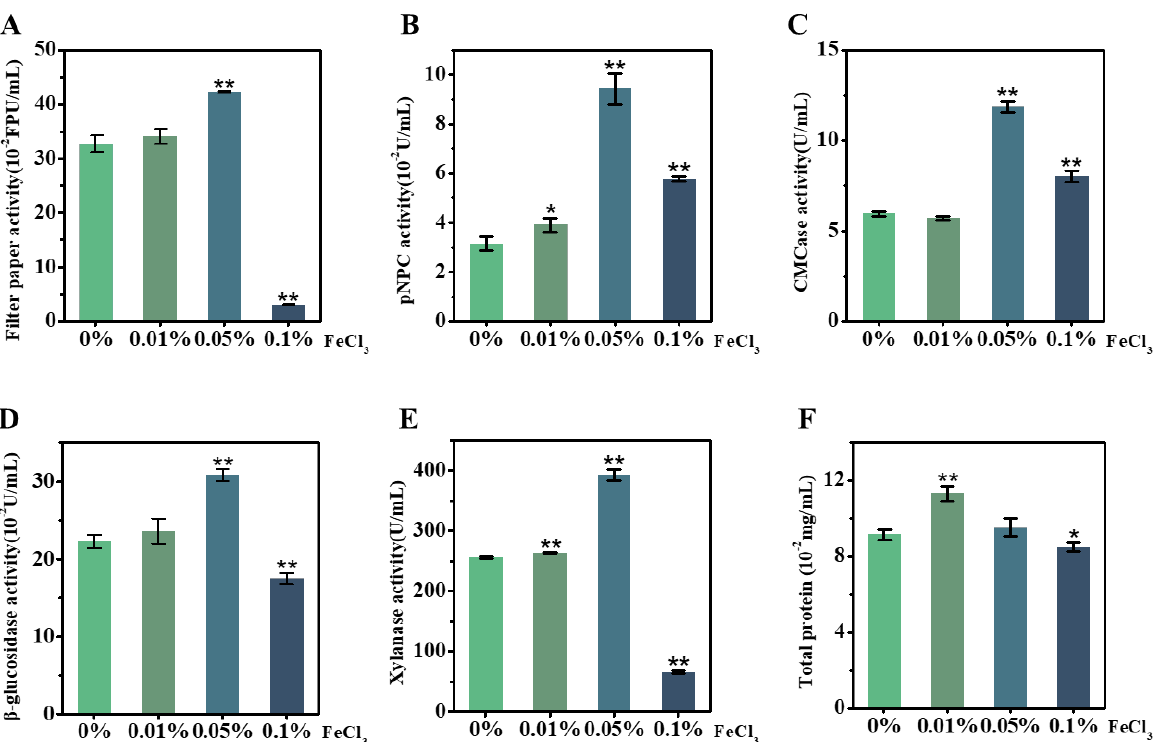
Figure 4. Activity assays in vitro of lignocellulose-degradation enzymes secreted by T. reesei incu- bation with raw stalk of ZH cultivar co-supplied with different concentrations of FeCl 3 in vivo. ( A ) Filter-paper activity; ( B ) CBH; ( C ) EG; ( D ) BG; ( E ) xylanase; ( F ) total protein of supernatant. Data as mean ± SD (n = 3); * or ** a significant difference between FeCl 3 -supplied samples and control (with- out FeCl 3 ) at p < 0.05 or 0.01 level.